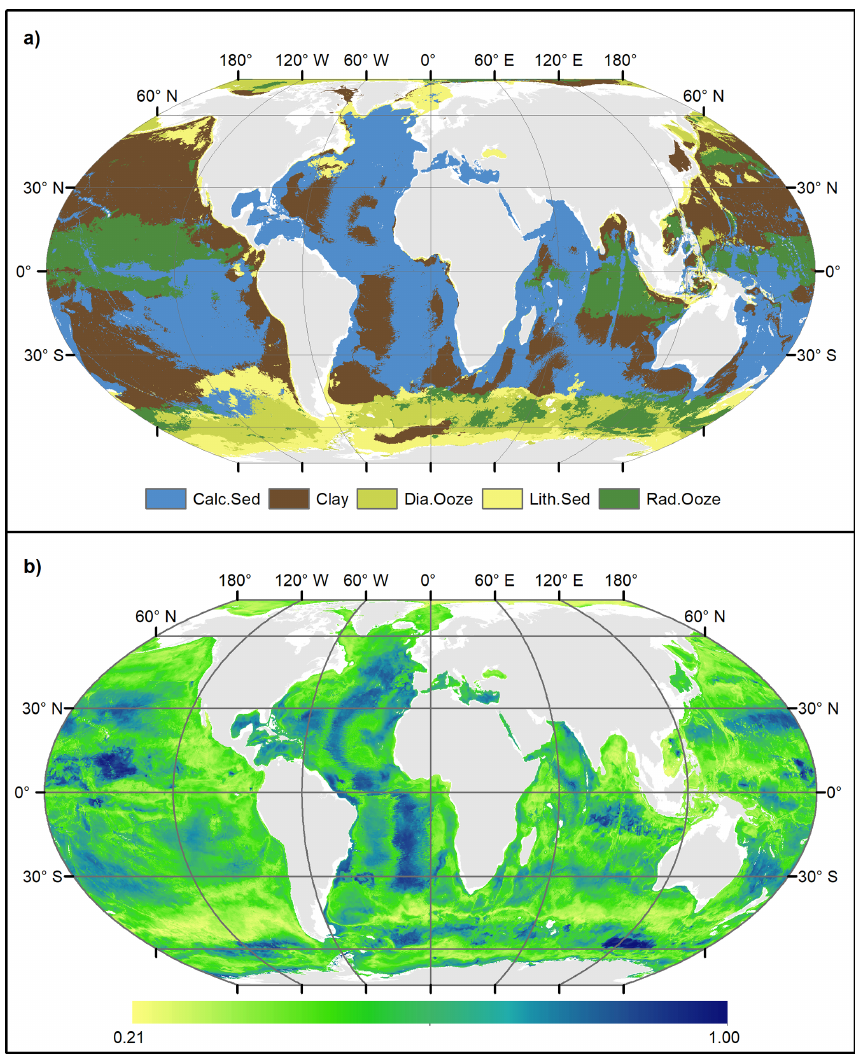
Figure 7. (a) Predicted lithology classes and (b) associated confidence in the predictions. Land masses are derived from ESRI